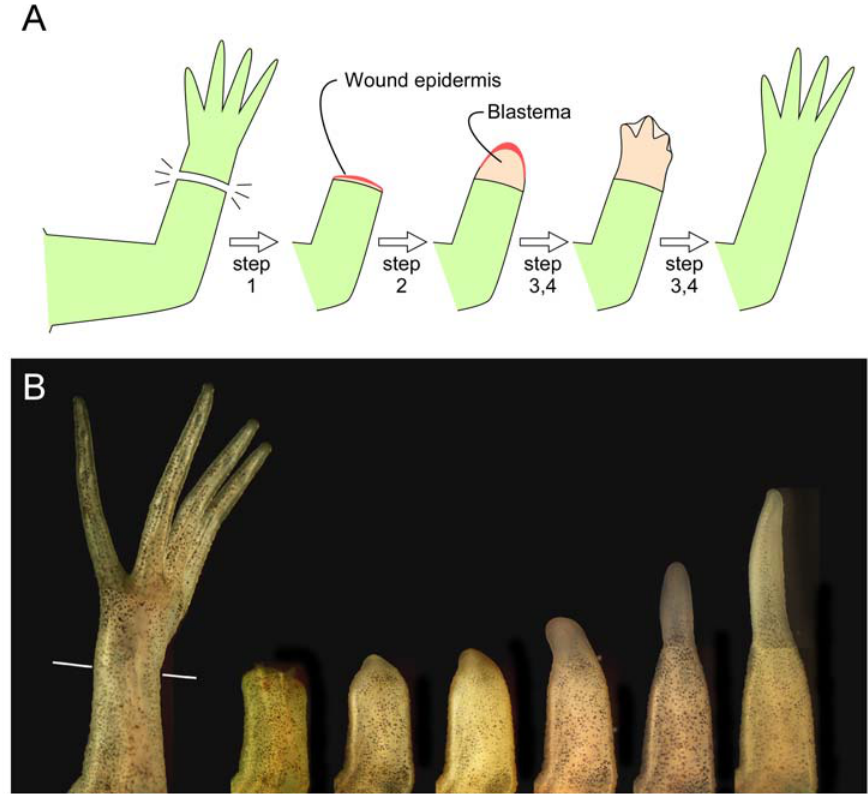
FIGURE 1. Limb regeneration in the urodele and X. laevis froglet. (A) A schematic representation of the process of limb regeneration in the urodele showing that the process can be divided into several overlapping steps. See text for details. (B) Spike formation in the X. laevis froglet forelimb. The right forelimb of a froglet (1.5–2 cm at snout-to-vent length) was amputated through the distal zeugopodium (indicated by a white line), and the amputation surface was trimmed to be flat. The animal was kept at 23– 24°C in dechlorinated tap water. Photographs show the intact limb before amputation and the stump at 0, 7, 10, 14, 21, 28 days after amputation (left to